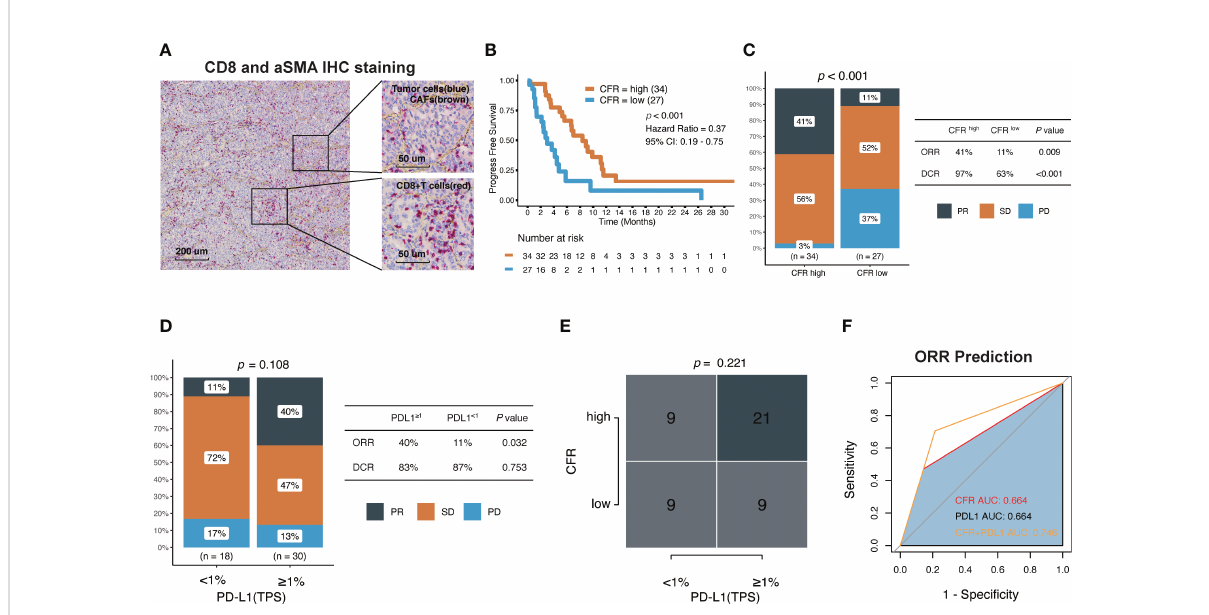
FIGURE 5 Association between CFR and clinical response to immune checkpoint inhibitors in Fujian Cancer Hospital cohort. (A) Representative images show double staining for a -SMA (brown) and CD8 (red). (B) Kaplan – Meier survival curves of PFS comparing CFR high group and CFR low group. (C) The ratio of patients with CR, PR, SD, and PD treated with anti-PD-(L)1 antibody in CFR high and CFR low group by chi-square test. (D) The ratio of patients with CR, PR, SD, and PD treated with anti-PD-(L)1 antibody in TPS ≥ 1% and TPS <1% using chi-square test. (E) A correlation between CFR and PD-L1 using chi-square test. (F) Receiver operating characteristic (ROC) analyses indicated that CFR plus PD-L1 (logistic regression model) harbored the highest area under the curve (AUC) (AUC = 0.746) compared with CFR and PD-L1 in NSCLC (AUC = 0.664 and 0.664, respectively). PD, progressed disease; PR, partial response; SD, stable disease; TPS, tumor proportion